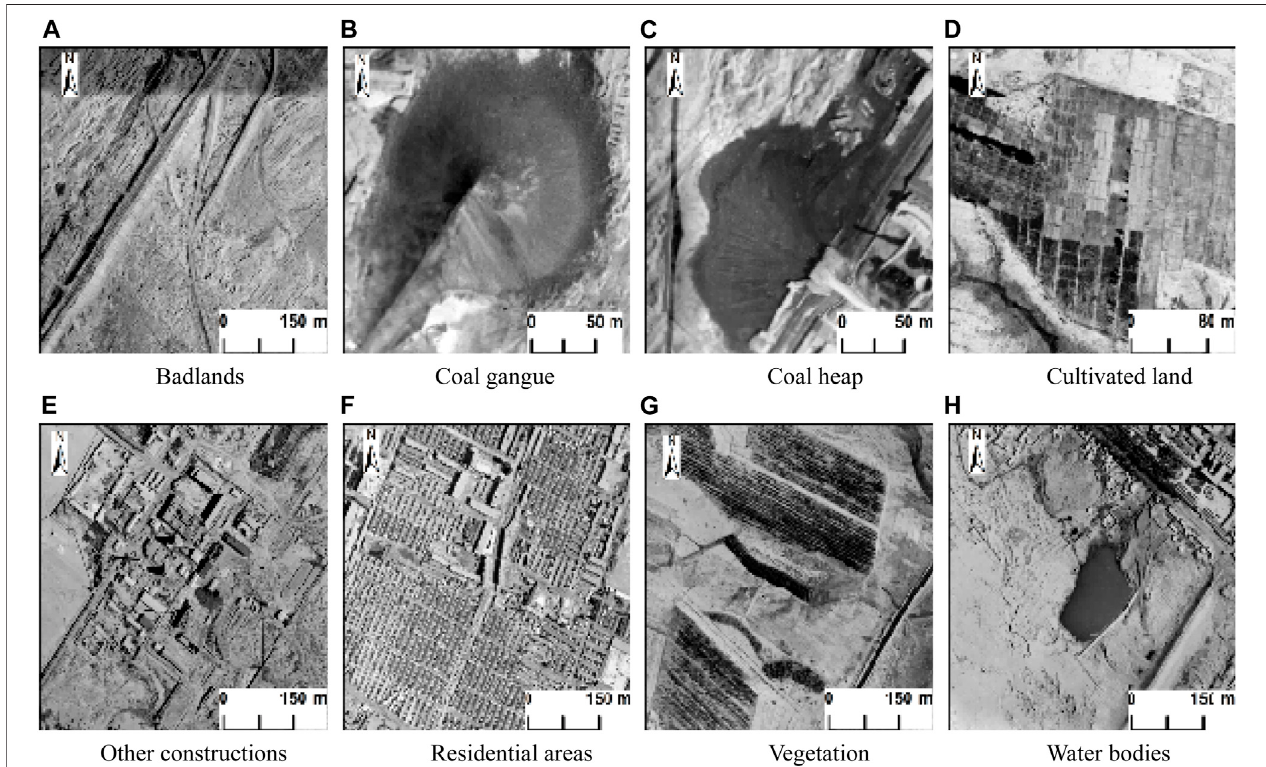
FIGURE 3 | Interpretation signs in aerial image. (A) Badlands, (B) coal gangue, (C) coal heap, (D) cultivated land, (E) other construction, (F) residential areas, (G) vegetation, and (H) water bodies.